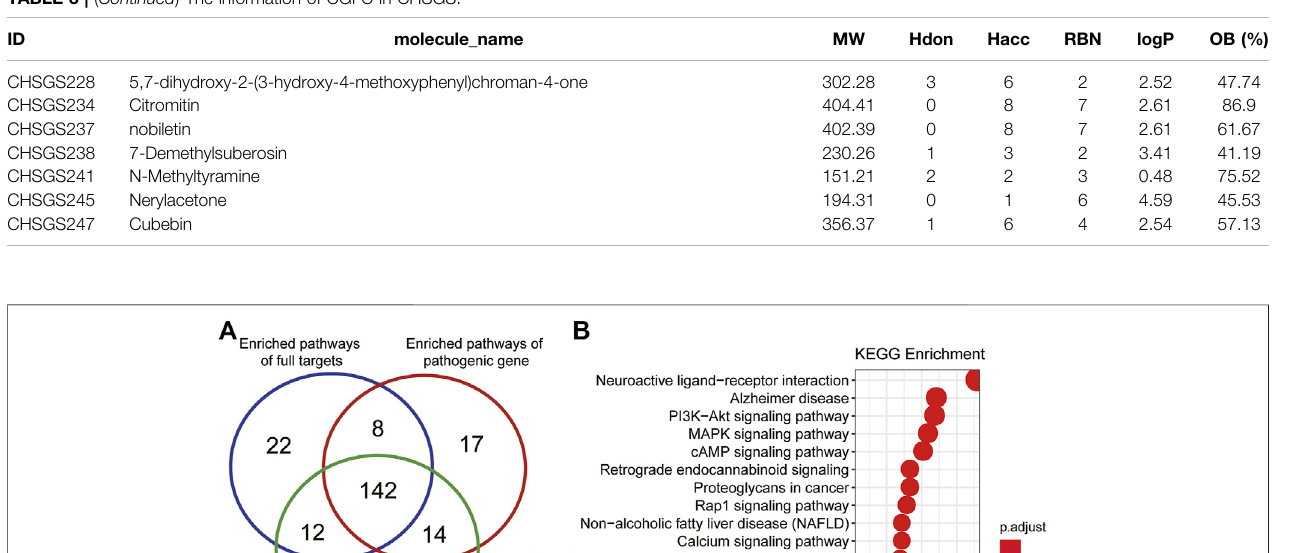
Frontiers in Pharmacology |